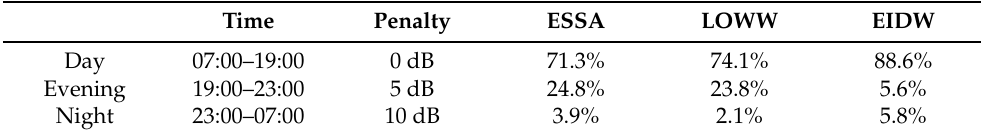
Table 1. Distribution of aircraft